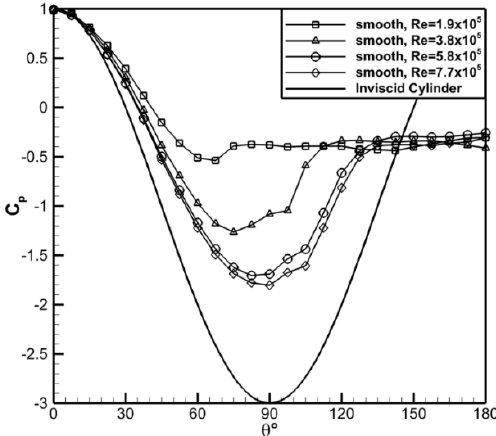
Figure 7. Surface pressure distribution for the smooth cylinder case.